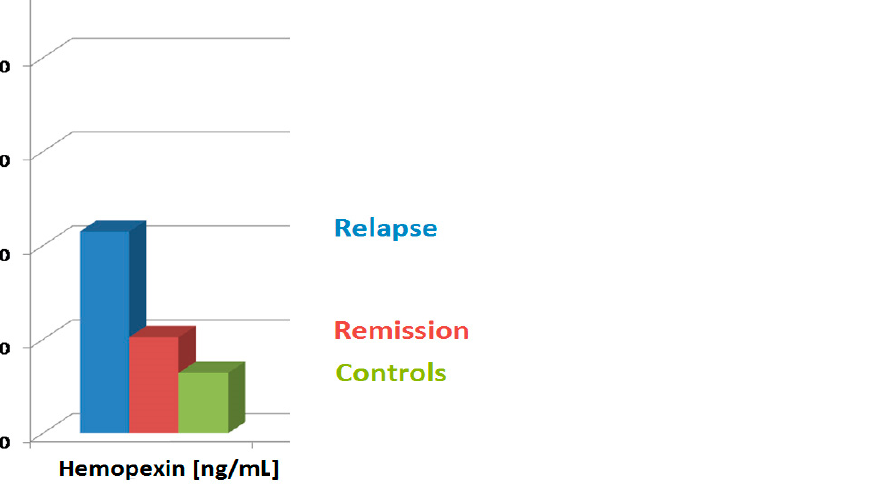
Figure 1. sHpx levels according to clinical phase of the disease, compared to control group. sHpx, serum hemopexin.